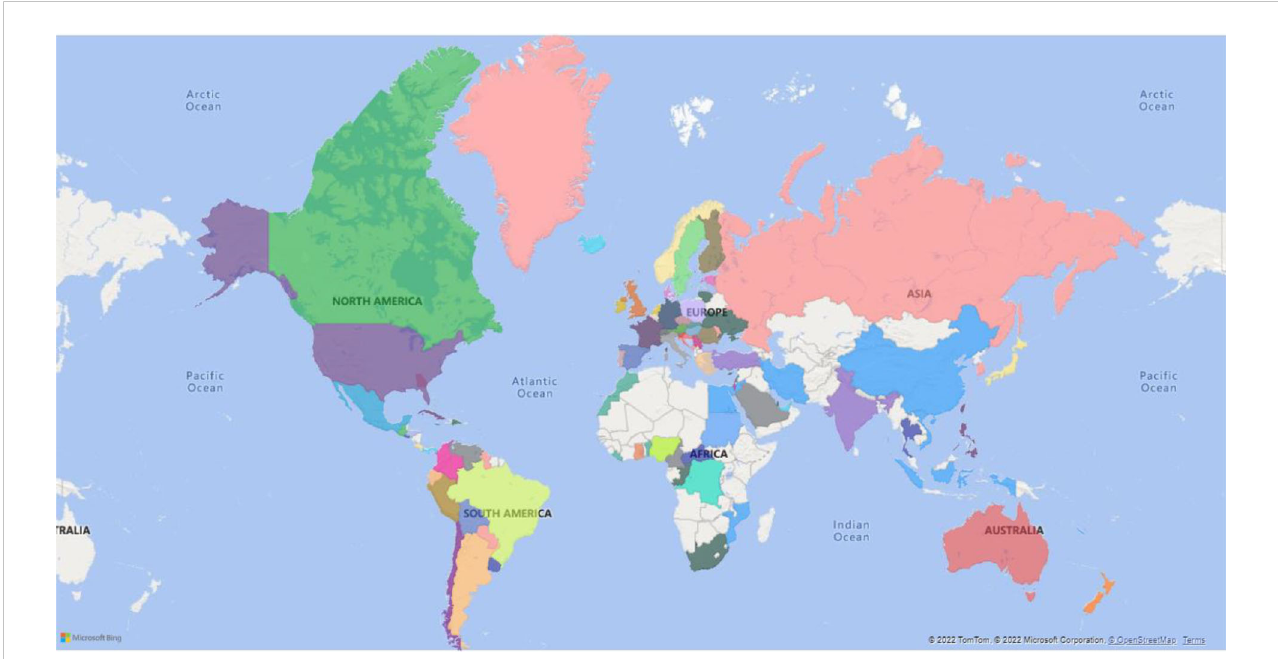
FIGURE 1 The global spread of monkey pox virus (MPV). The fi gure is prepared using PowerBI